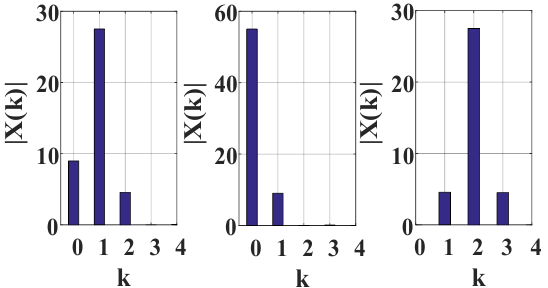
Figure 2. ApDFT results of the fundamental, DC, and second harmonic components. The proposed e-apDFT algorithm can be used to estimate and compensate for the effect of spectral leakage caused by the DC component and the second harmonic. In order to achieve this goal, the degree of the spectral leakage of each component on two observable, adjacent apDFT bins needs to be obtained. More specifically, their ratio, which is called the spectral interference rate, δ , in this paper, should be calculated. The apDFT results are divided into the real spectrum and the imaginary spectrum, and the corresponding spectral interference rates are denoted as δr and δi , respectively. A conclusion is drawn by analyzing the apDFT results of a large number of signals with different amplitudes, frequencies, and phases; when the frequency is fixed, δr and δi are constant (as shown in Figure 3). According to this conclusion, the interference caused by the DC component and the second harmonic component can be analyzed independently.